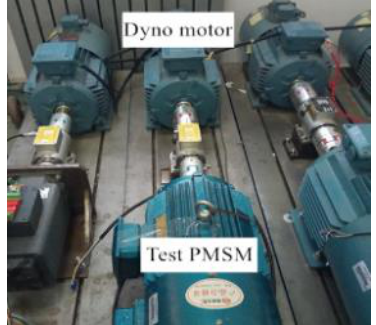
Figure 5. Practical test platform of the PMSM.